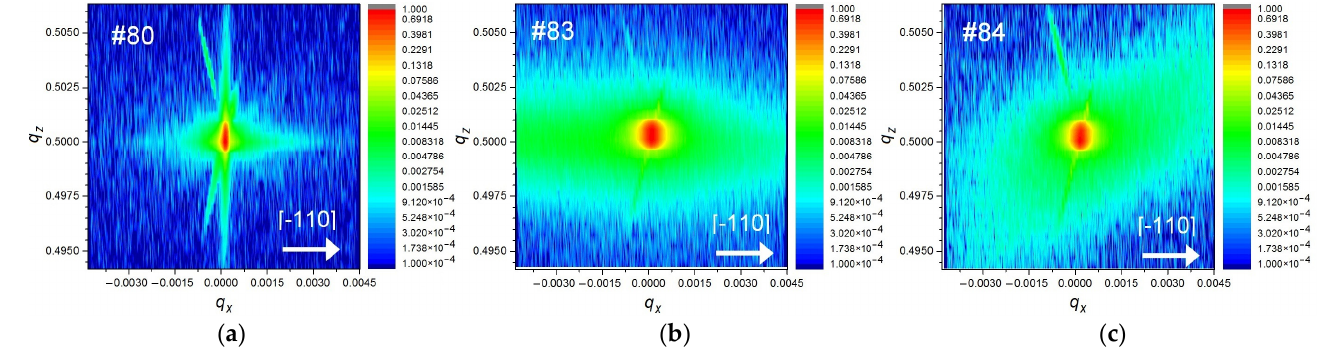
Figure 9. The experimental RSMs for the samples #80 ( a ), #83 ( b ), #84 ( c ) near the (220) reciprocal lattice point. The arrow marks the crystallographic direction [1(cid:3364)10] (according to the direction of the base cut, which was indicated by the arrow on the samples). The intensity is normalized to the peak intensity for each of the RSMs.